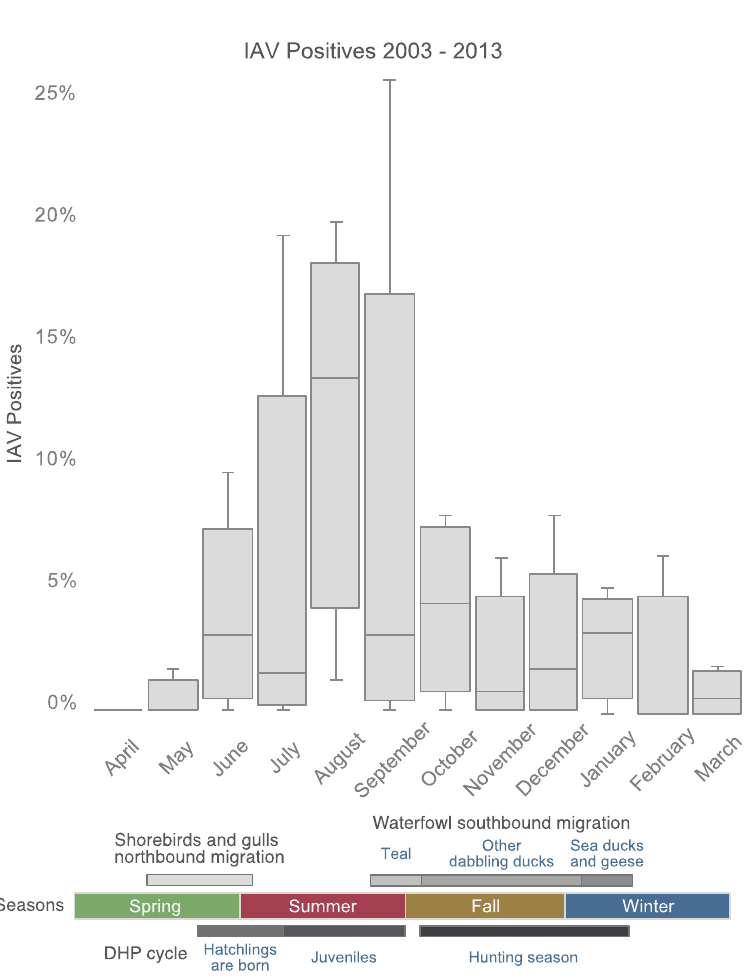
Figure 1. Seasonal timing of influenza A viruses (IAVs) in Maryland duck hunting preserves. The proportion of samples collected from mallards in the DHPs during each month that tested positive for IAV is indicated by the height of the column. The upper and lower whiskers represent the maximum and minimum, respectively. From top to bottom, the first, second and third lines of the rectangles represent the first, second (median) and third quartiles. Data are summarized over eleven years from 2003–2013. Below, the seasonal timing of when DHP mallards hatch and become susceptible juveniles is described, as well as the arrival to the Delmarva Peninsula of shorebirds and gulls during their northbound migration, and migratory waterfowl during their southbound